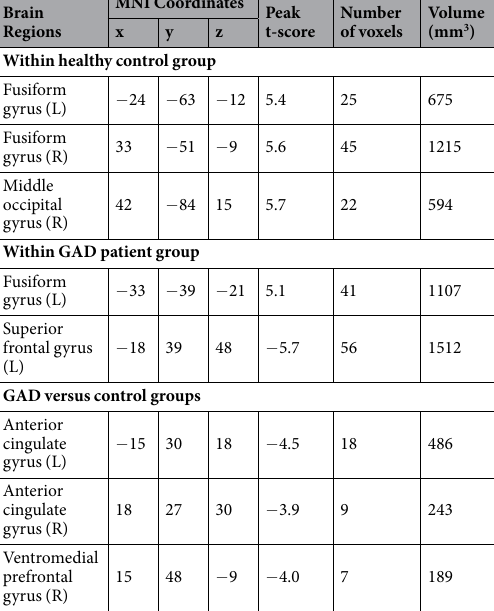
signal change was lower in the GAD sample. In contrast, the percent BOLD signal change in the right IFG response to evaluating neutral stimuli peaked later in the adolescents with GAD compared to HCs. Behaviorally, we observed significantly increased reaction time in GAD patients for neutral picture evaluation, but not for negative stimulus evaluation. Due to low arousal level, it is more difficult to evaluate neutral than negative stimuli. Furthermore, pathological worry, the hallmark of GAD, has been linked to deficits in executive processes 46 . It is possible that delayed neural response in the right IFG during neutral stimuli evaluation underlies the observed prolonged reaction time.